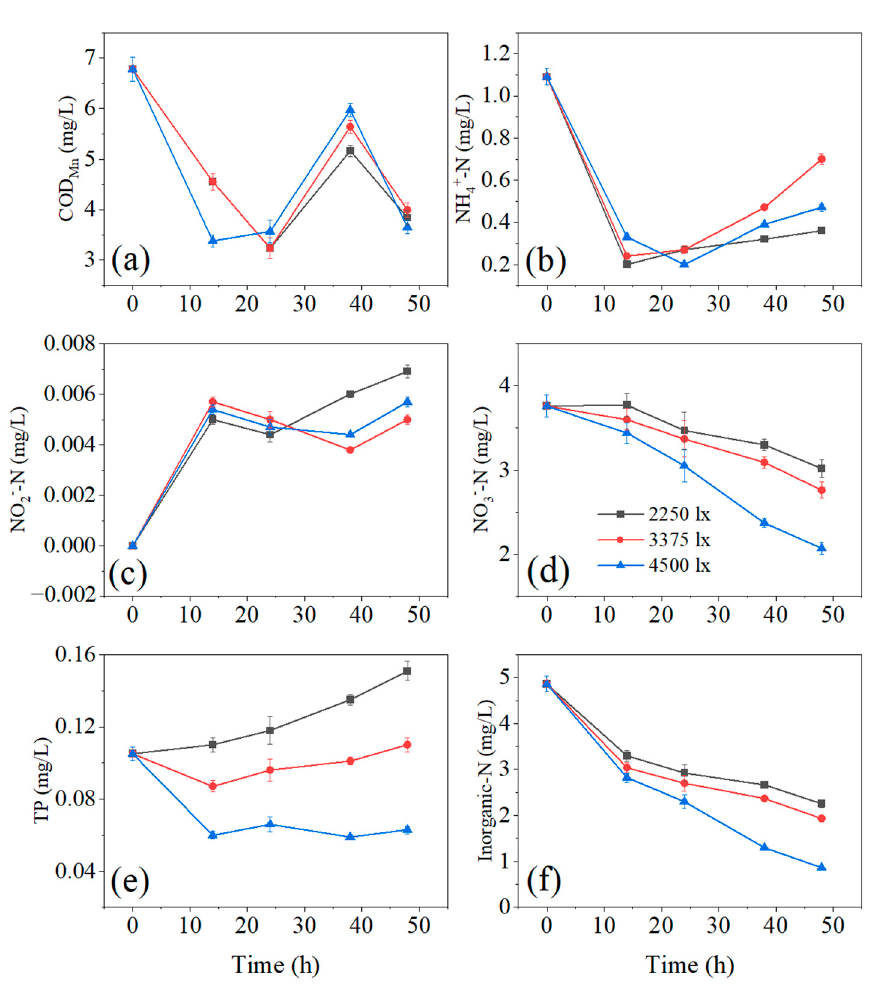
Figure 3. The pretreatment results of synthetic micro-polluted water under different light intensities: ( a ) COD Mn , ( b ) NH 4+ -N, ( c ) NO 2 − _ N, ( d ) NO 3 − _ N, ( e ) TP and ( f ) inorganic nitrogen.